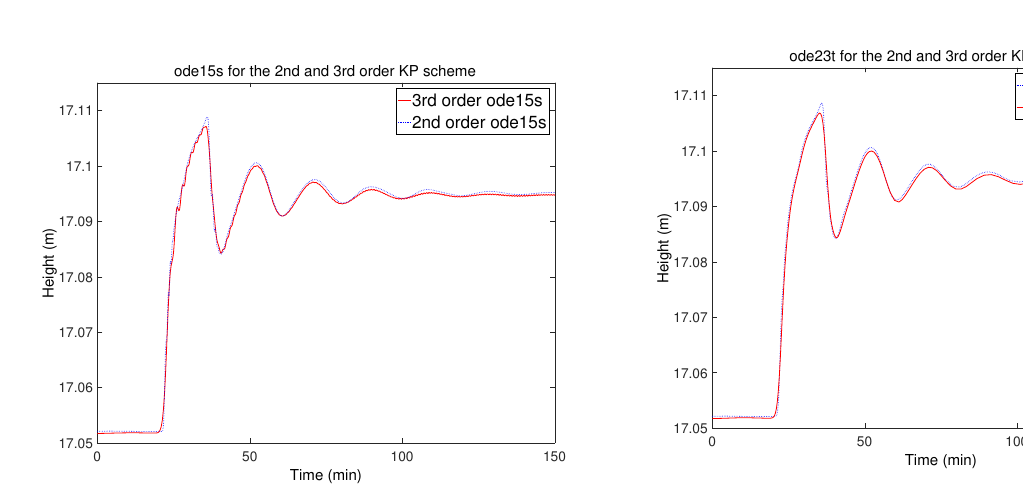
Figure 11: ode23t for 2 nd and 3 rd order KP